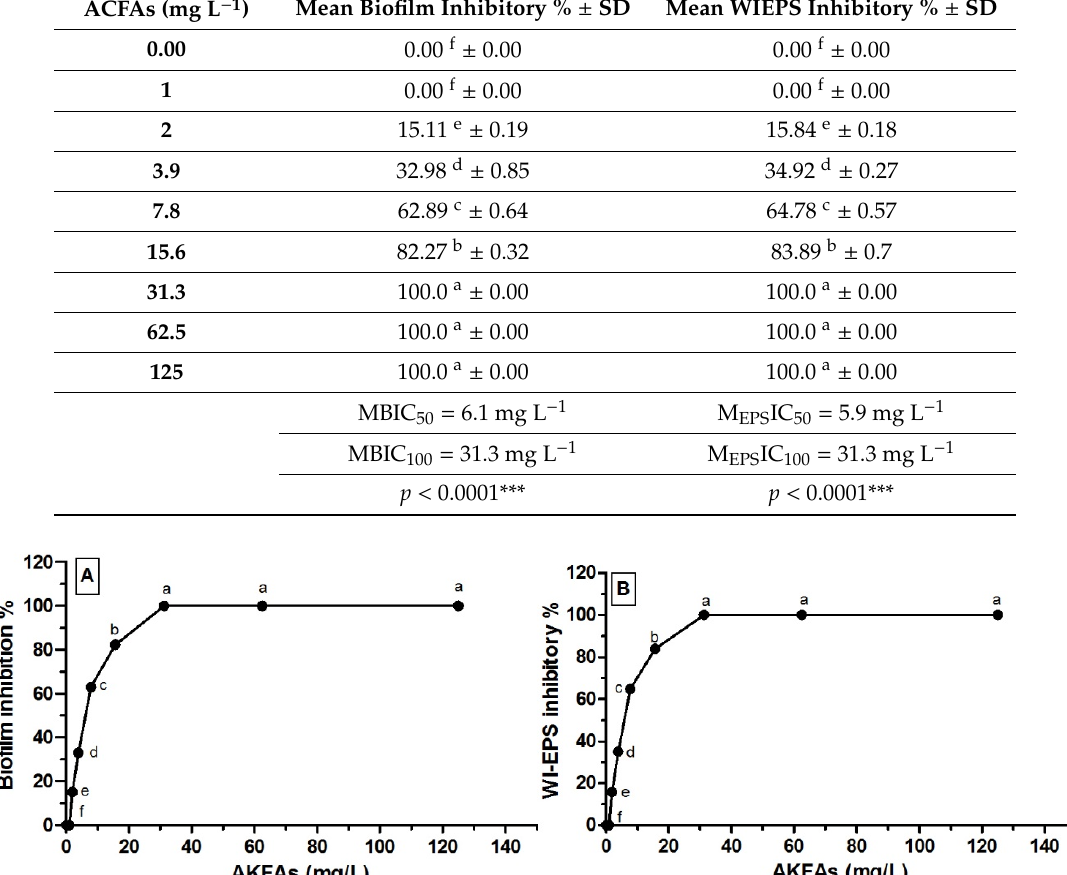
Figure 3. Antivirulence activity of Arthrographis kalrae fatty acids (AKFAs). ( A ) AKFAs inhibitory activity against S. mutans biofilm formation in ( p < 0.0001) . ( B ) WI-EPS inhibitory activity of AKFAs against S. mutans ( p < 0.0001) . Different letters indicate significant differences between AKFAs concentrations according to Tukey post hoc test at p < 0.05 in both ( A ) and ( B ).